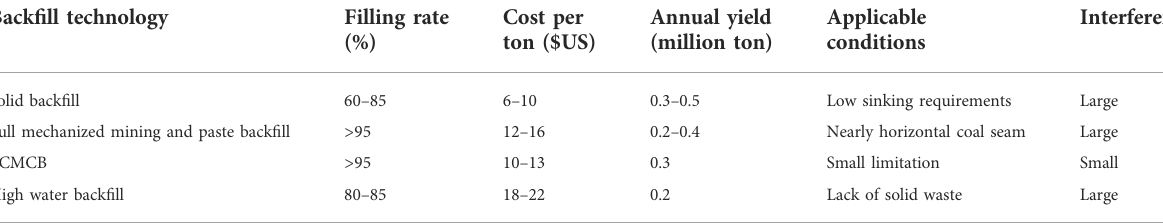
TABLE 7 Technical and economic comparisons of several back fi ll